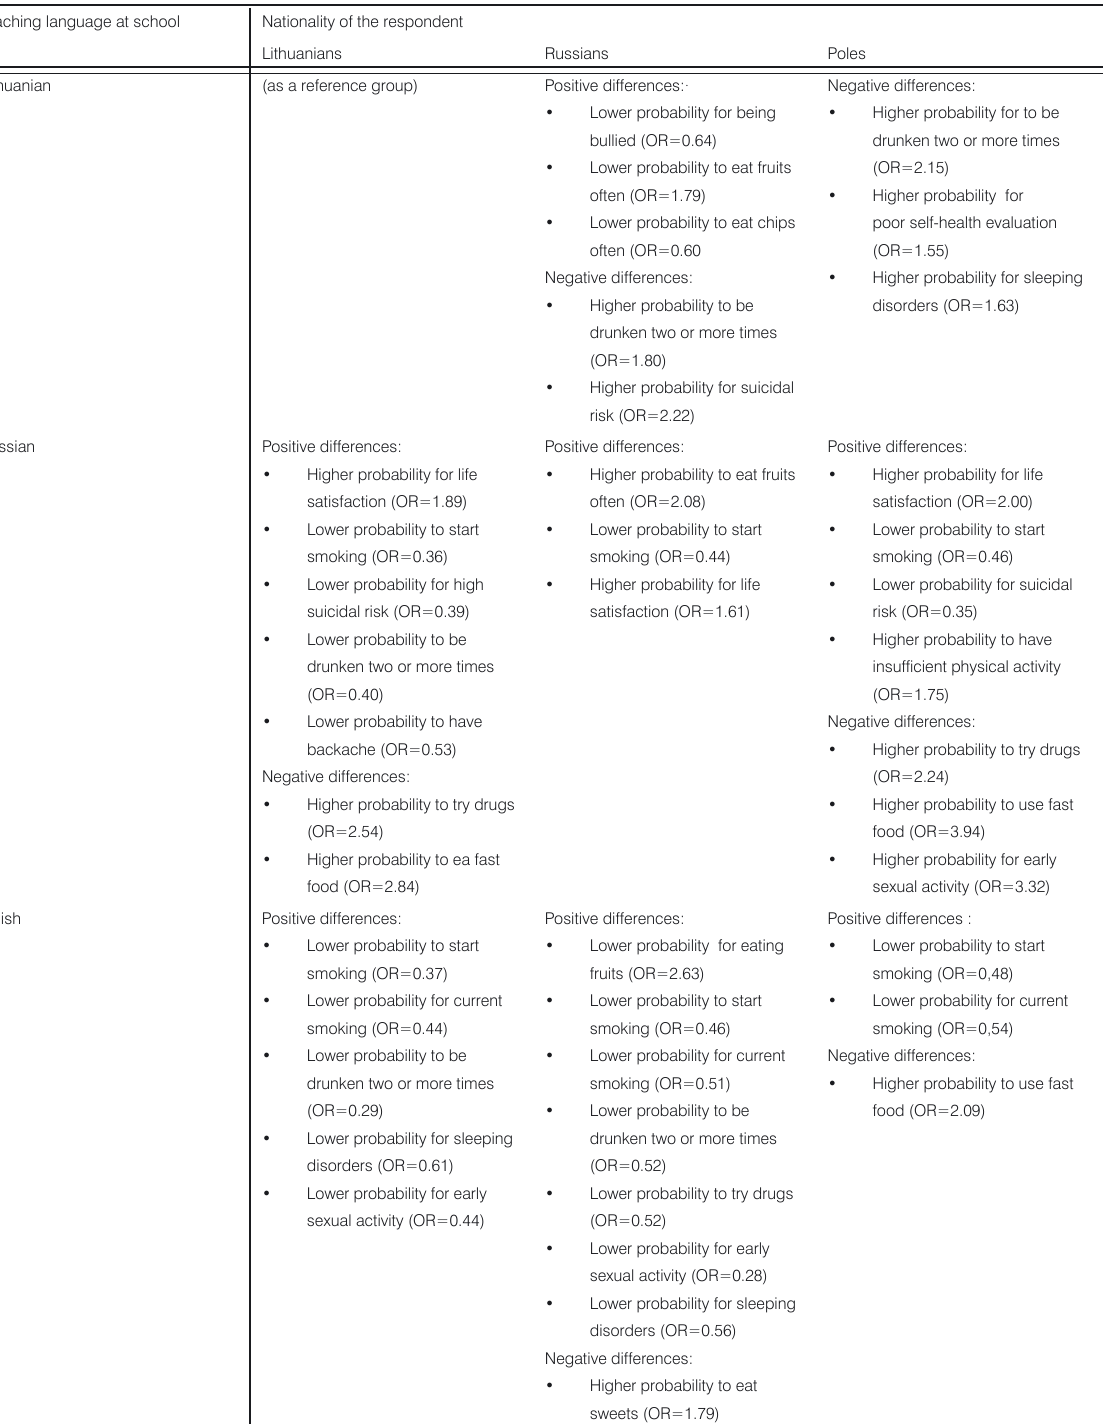
Table 5. Odds ratios for health behavior indicators by nationality and teaching language at